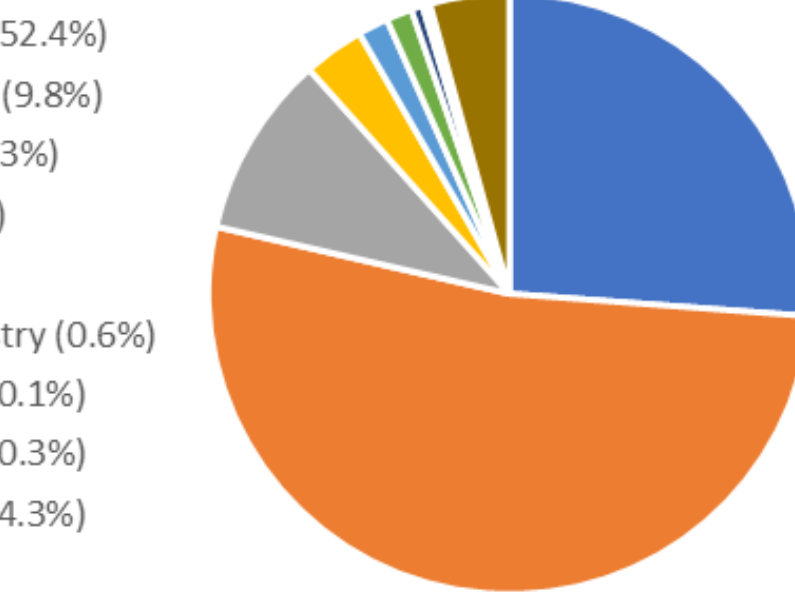
Figure 1. Contribution from different CO 2 emission sources towards the atmosphere across the globe (Reprinted with permission from ref. [26]).